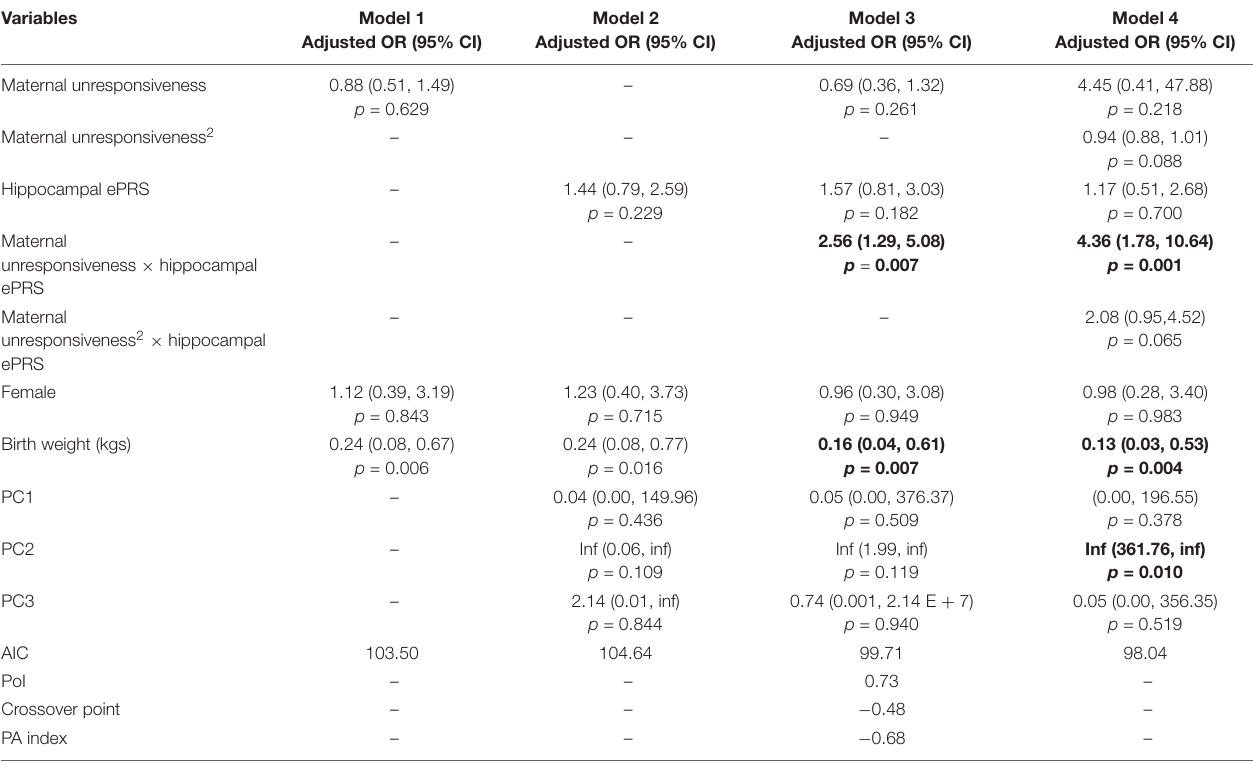
TABLE 5 | Associations among maternal unresponsiveness, hippocampal gene network for ePRS, covariates, and disorganized versus organized attachment pattern.